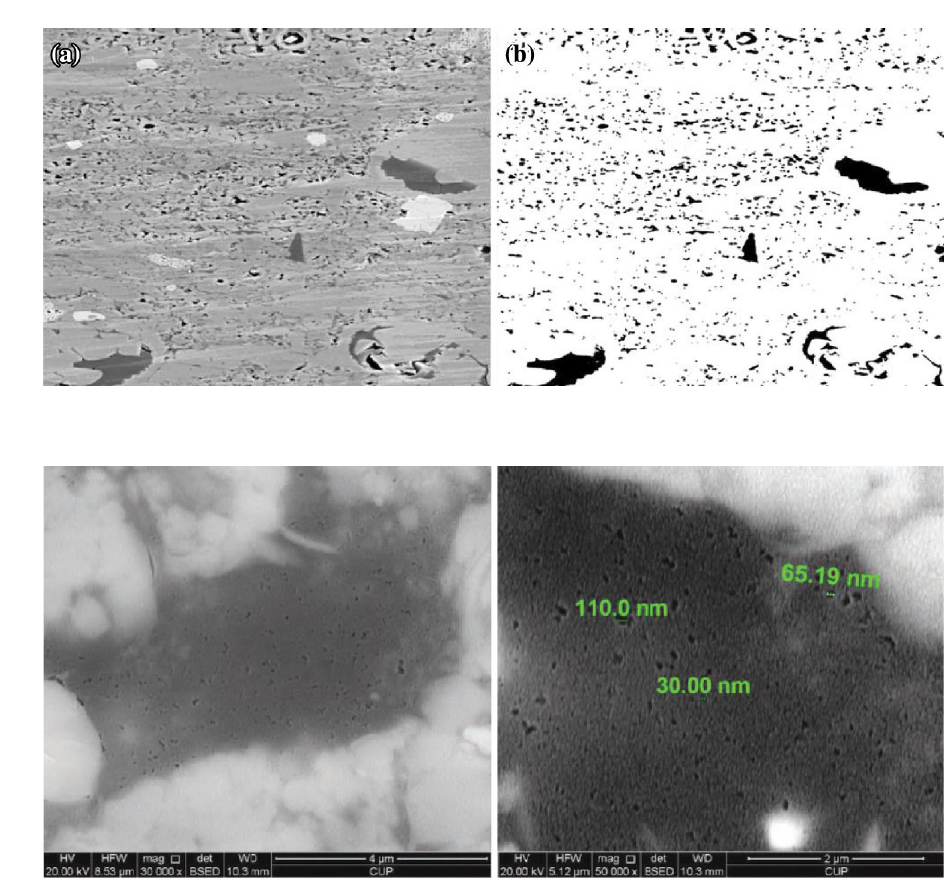
Fig. 1 A cross-section of a SEM image of a shale sample: a unsegmented and b segmented. Reproduced with permission from (Walls and Sinclair 2011; Song et al. 2018)